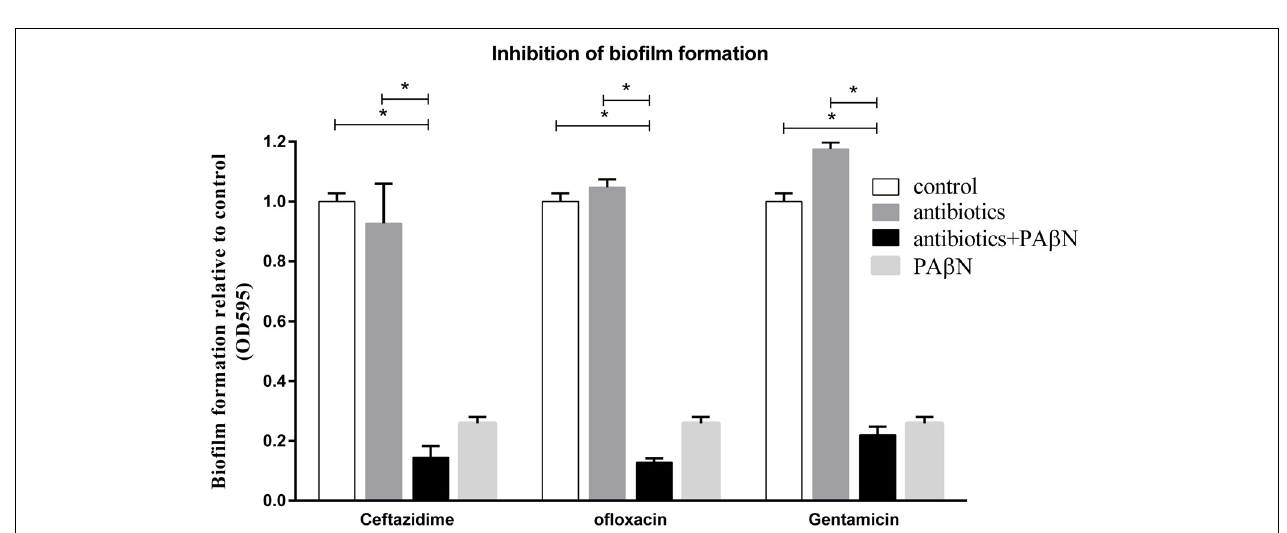
FIGURE 5 | Inhibition of biofilm formation of A. pleuropneumoniae by antibiotics with or without the EPI PA β N. Biofilm formation of the WT strain SC1516 was significantly inhibited by subinhibitory concentrations of antibiotics (0.25 µ g/ml of ceftazidime, 0.0625 µ g/ml of ofloxacin or 1 µ g/ml of gentamicin) in combination with PA β N (60 µ g/ml). Asterisks indicate statistical significance using two-way ANOVA ( ∗ P <